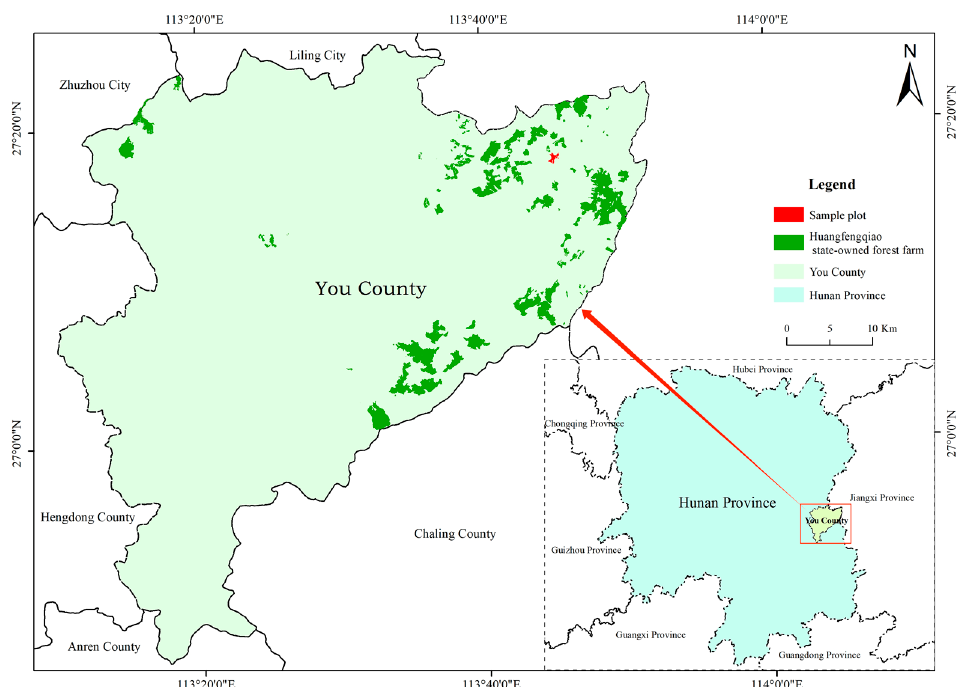
Figure 1. Location of s tudy area. Table 1. Statistical table of tree factors in the sample plot.